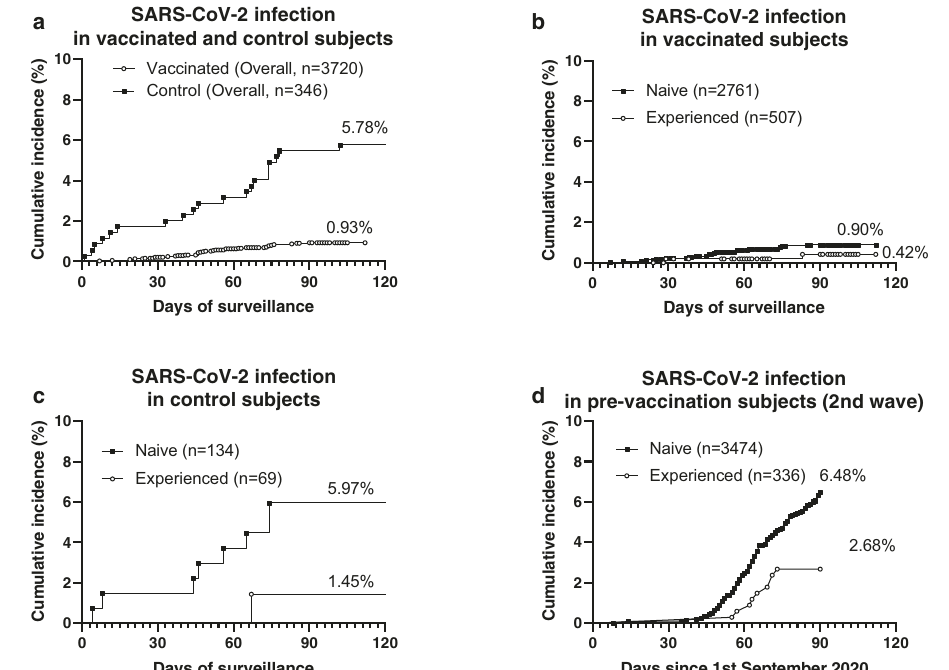
Fig. 2 SARS-CoV-2 infection in vaccinated and non-vaccinated healthcare workers of San Matteo hospital. a Cumulative incidence of SARS-CoV-2 infection in vaccinated subjects and non-vaccinated controls. b Cumulative incidence of SARS-CoV-2 infection in SARS-CoV-2-naïve and experienced vaccinated subjects. c Cumulative incidence of SARS-CoV-2 infection in SARS-CoV-2-naïve and experienced non-vaccinated control subjects. d Cumulative incidence of SARS-CoV-2 infection in SARS-CoV-2-naïve and experienced subjects before vaccine implementation during the second pandemic wave (period: September 1st-November 30th 2020).